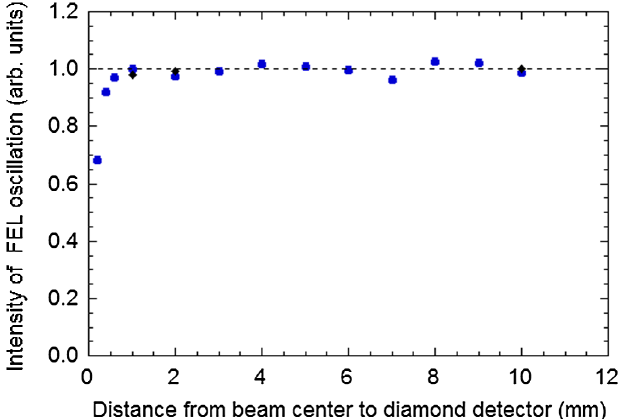
mm.)FIG. 15. Effect of distance from beam center to diamond-based detector on FEL oscillation. The intensity of FEL oscillation (verticalaxis)wascalculatedfrom anoutputsignalofaphotodiode.